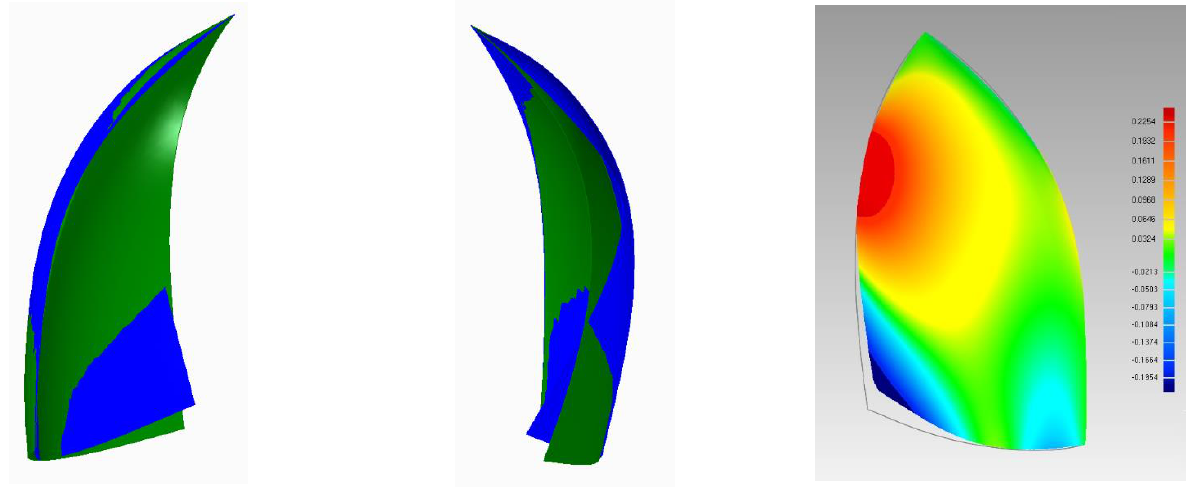
Figure 16. Design shape (green), flying shape (blue), and map of the 3D deviations [m] for AWA = 110° and Δ α g = 15°.